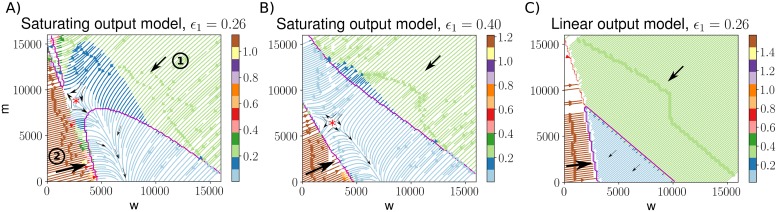
Locally optimal controls show nonlinear behaviours close to demand-satisfying regions, but linear optimal dynamics far away from these regions.Streamplots in (w, m)-space show the dynamics resulting from a locally optimal control, for various parameters of ϵ1. At each point, arrows show the direction corresponding to the largest decrease in cost. Regions are coloured according to the magnitude of the decrease in cost when moving in the optimal direction. Black arrows illustrate general trends in these regions. A: Region (1) shows that at high copy numbers, both mutant and wildtype mtDNAs should be decreased in an evenhanded manner; region (2) shows the possibility that the optimal control involves an increase in mutant copy number. B: A higher value for the parameter ϵ1 is used, meaning mutants are less pathological. C: the locally optimal control for the linear output model more closely resembles a linear control. In both (A) and (B) we see a divergence point (red asterisk) illustrating the fact that both high mutant and high wildtype states constitute local attractors of low cost (as in Fig 2).